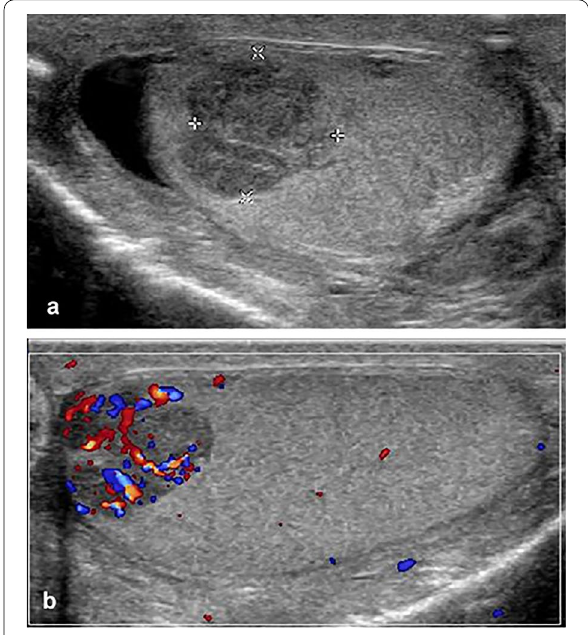
Fig. 2 a Testicular US shows a well-circumscribed, encapsulated mass at the upper pole of the right testicle, measures 1.1 x 1.1 cm. b Color Doppler image shows significant internal vascularity of mass